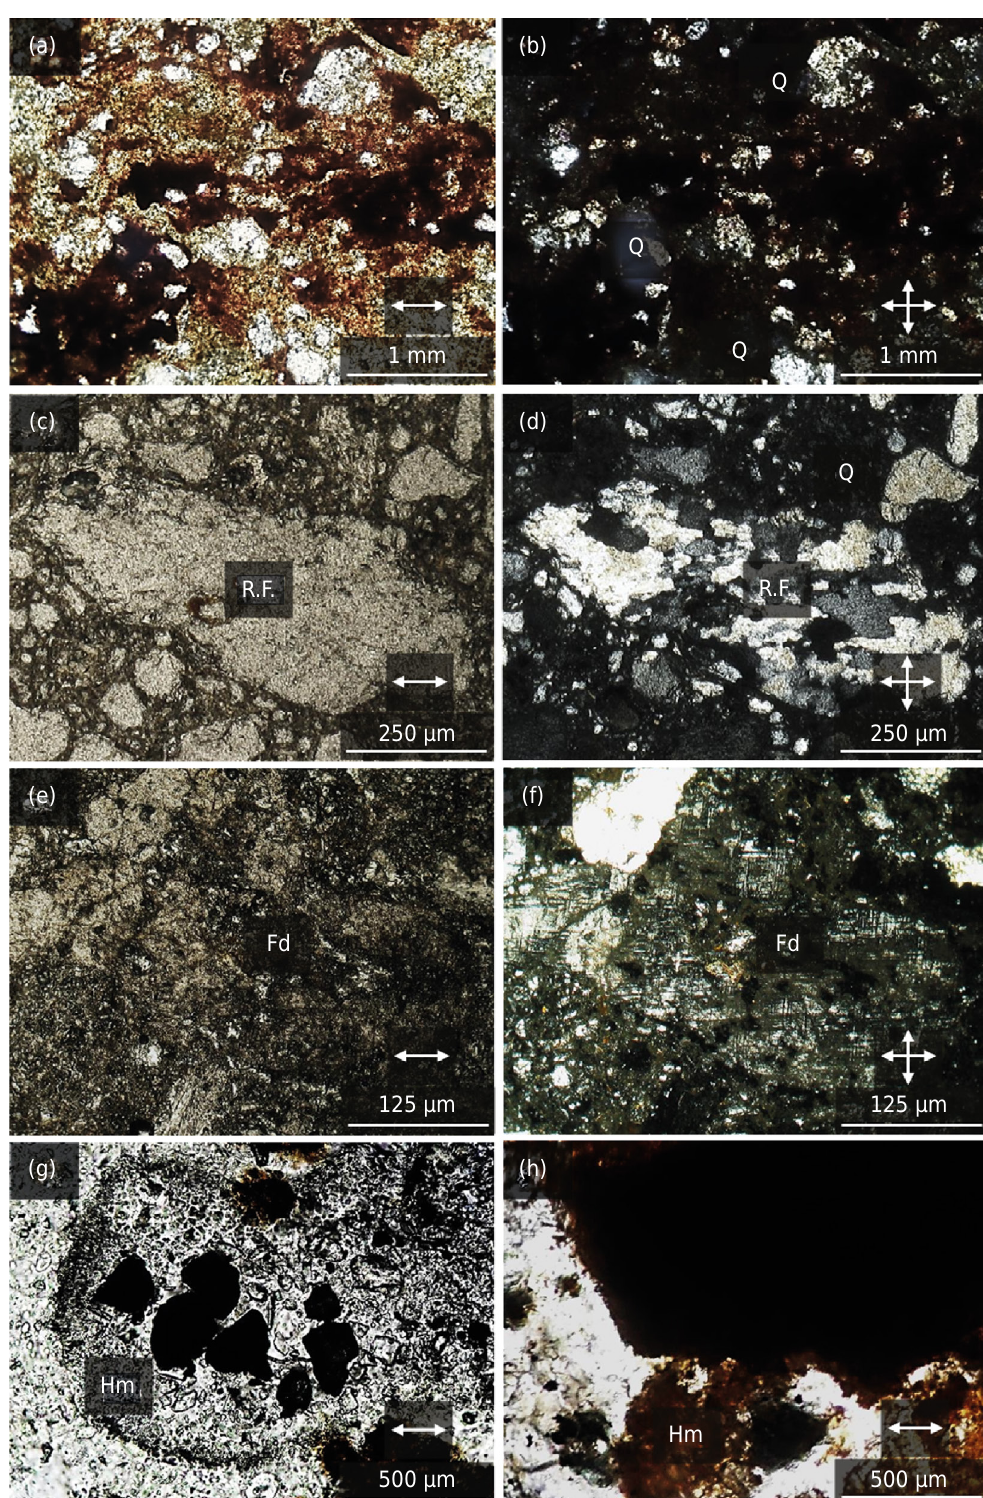
Figure 3. Optical microscopy photographs of alteration features of the quartz, potassium feldspar, and rock fragments in the profiles. (a) Quartz crystals slightly altered in the sand fraction of the Bi2 horizon in P1 (ppl); (b) Quartz crystals slightly altered in the sand fraction (xpl); (c) Fragment of rock formed by quartz in the sand fraction of the BC3 horizon in P2 (ppl); (d) Fragment of rock formed by quartz in the sand fraction (xpl); (e) Potassium feldspar in the sand fraction of the BC3 horizon in P2 (ppl); (f) Potassium feldspar in the sand fraction (xpl); (g) Opaque minerals, probably primary hematite or magnetite, in the Bt3 horizon of P3 (ppl); and (h) Opaque minerals, probably primary hematite or magnetite, with a strong alteration in the Bt horizon in P4 (ppl). Q: quartz; R.F.: rock fragment; Fd: feldspar; Hm: